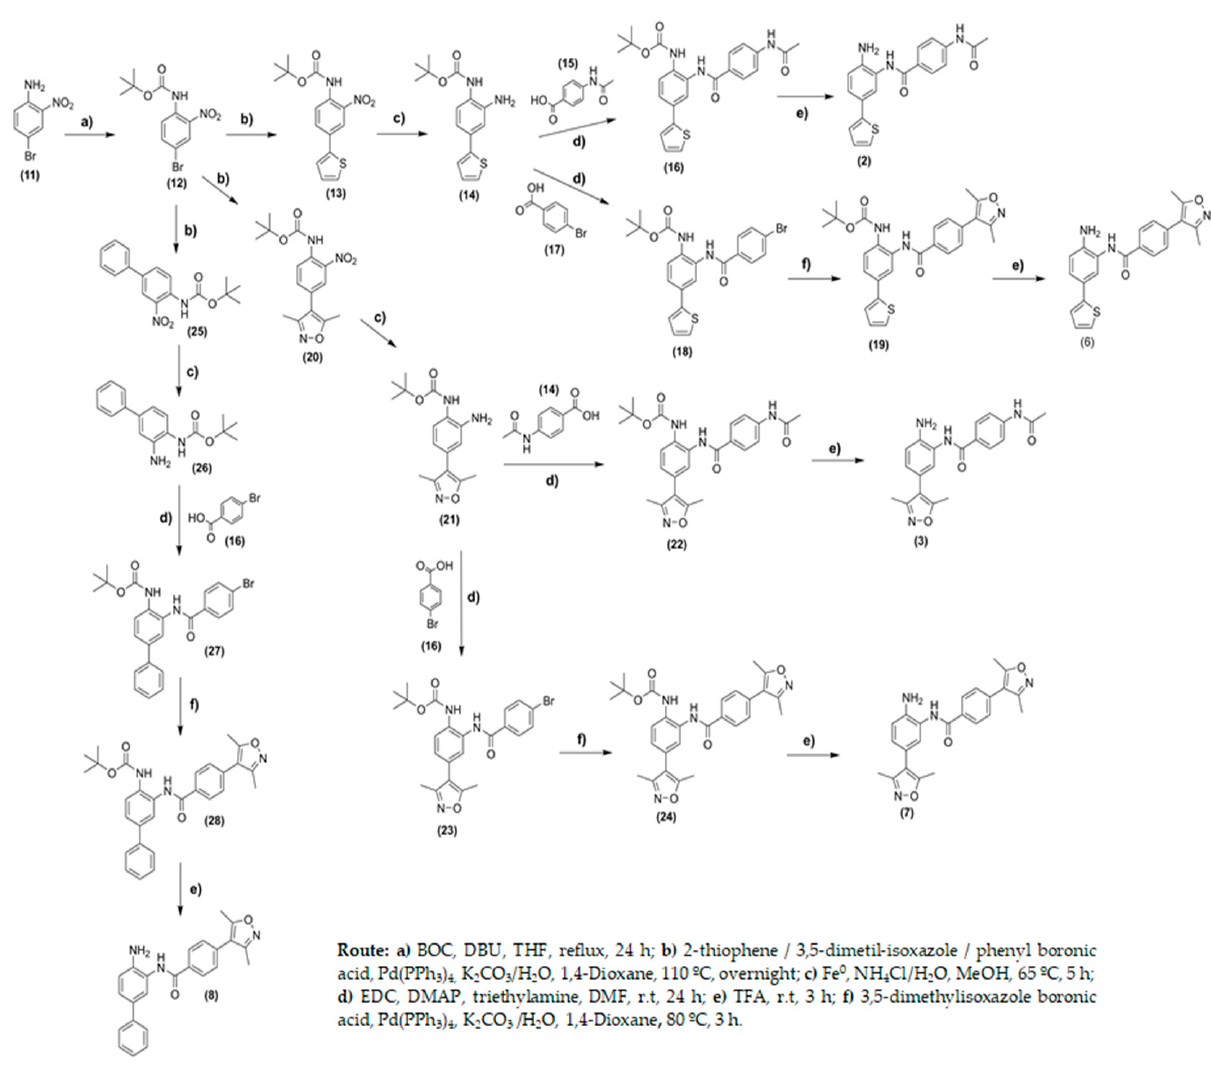
Figure 5. Synthesis of compounds ( 2 ), ( 3 ), ( 6 ), ( 7 ), and ( 8 ). Both 4-fluoro-2-nitro-benzamides ( 9 and 10 ) were obtained from the coupling reac- tions with 4-(3,5-dimethylisoxazol-4-yl)benzoic acid ( 32 ) or 4-acetamidobenzoic acid ( 15 ), respectively. The reactions used 1-[bis(dimethylamino)methylene]-1H-1,2,3-triazolo[4,5- b]pyridinium 3-oxide hexafluorophosphate (HATU) as a coupling reagent, and the yields were 55% ( 9 ) and 26% ( 10 ) (Figure 6). Analytical methods, including infrared (IR) spec- troscopy, mass spectrometry, and 1 H and 13 C nuclear magnetic resonance (NMR) spec- troscopy, were used to characterize the chemical structures. For all compounds ( 1 – 10 ),